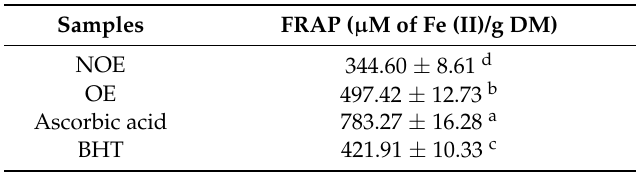
Table 6. The antimicrobial activity of optimized and non-optimized extracts from mangosteen pericarp; ID: diameter of inhibition (mm).